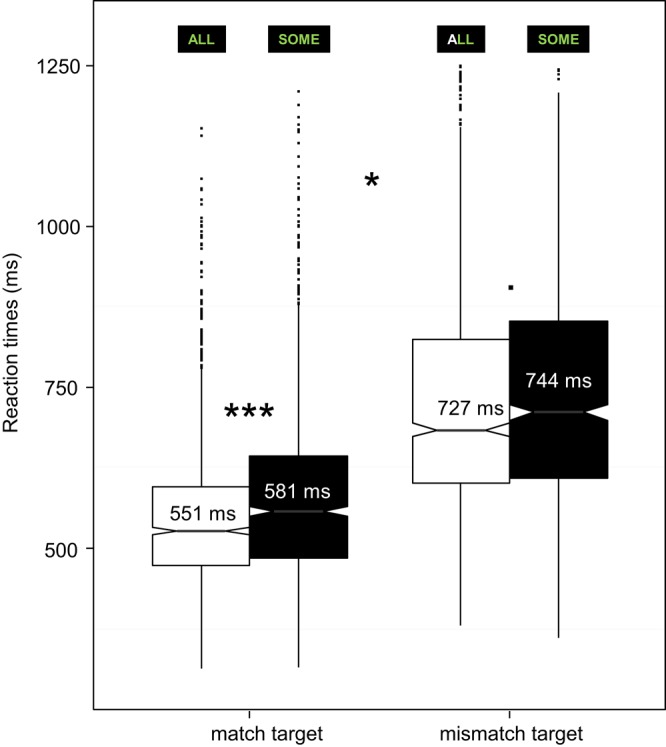
Reaction times to target-ALL and target-SOME depending on the match and mismatch target Block type. Notches give a roughly 95% confidence interval for comparing medians (see e.g., McGill et al., 1978). Integers in the boxes indicate means. ***p < 0.001, **p < 0.01, *p < 0.05, ▪p < 0.1.